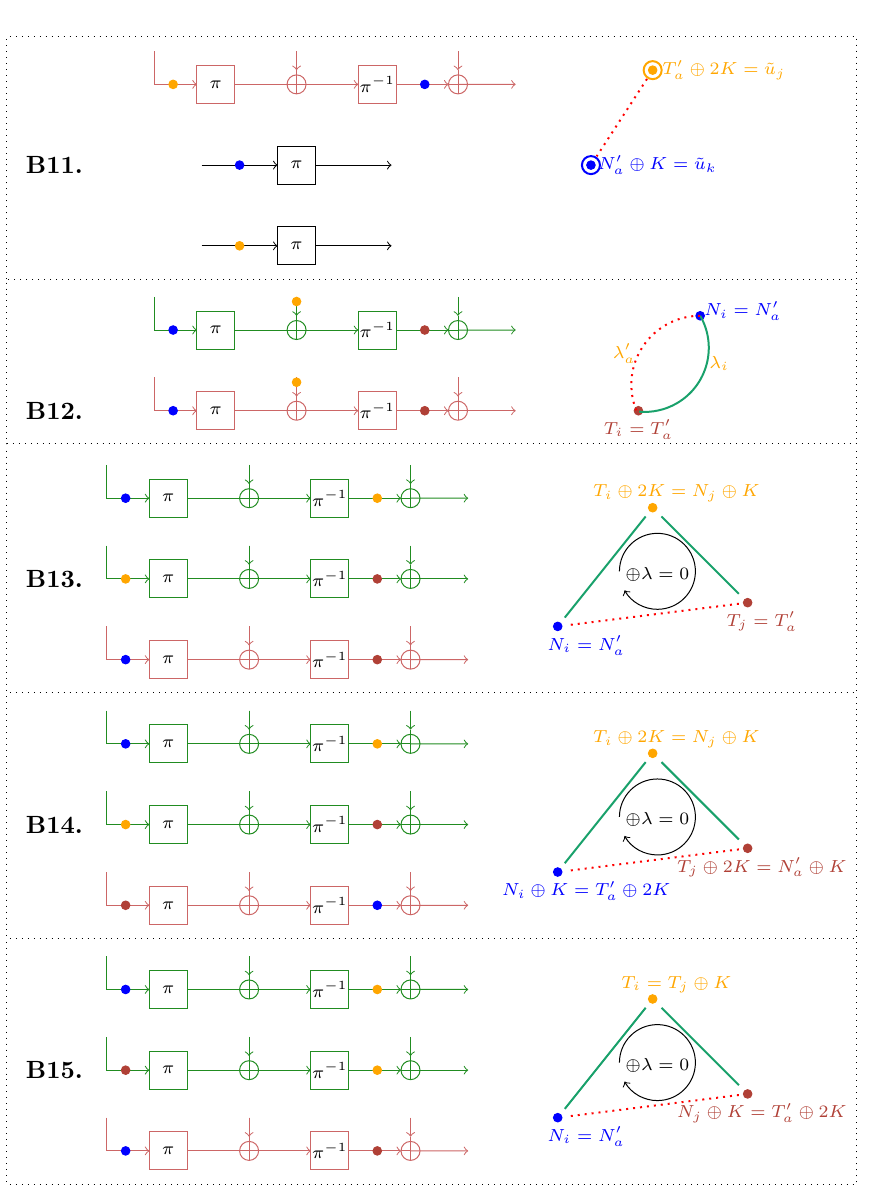
Figure 11: Collisions of verification queries with authentication and/or primitive queries - Figurative and graphical representations of the bad